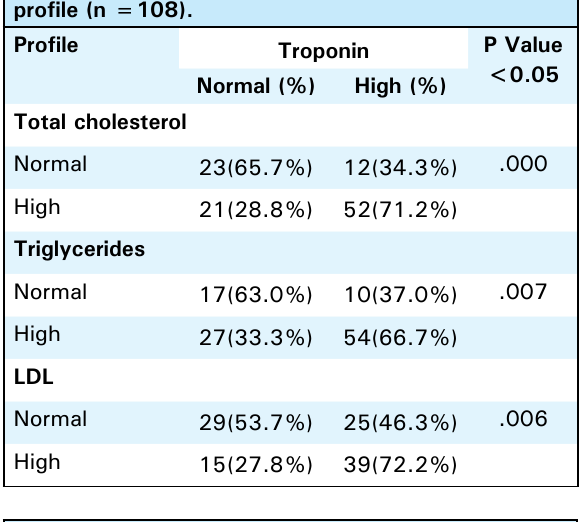
table 5. Correlation between Troponin and Lipid profile (n =108).